Question: What form of chart is displayed?
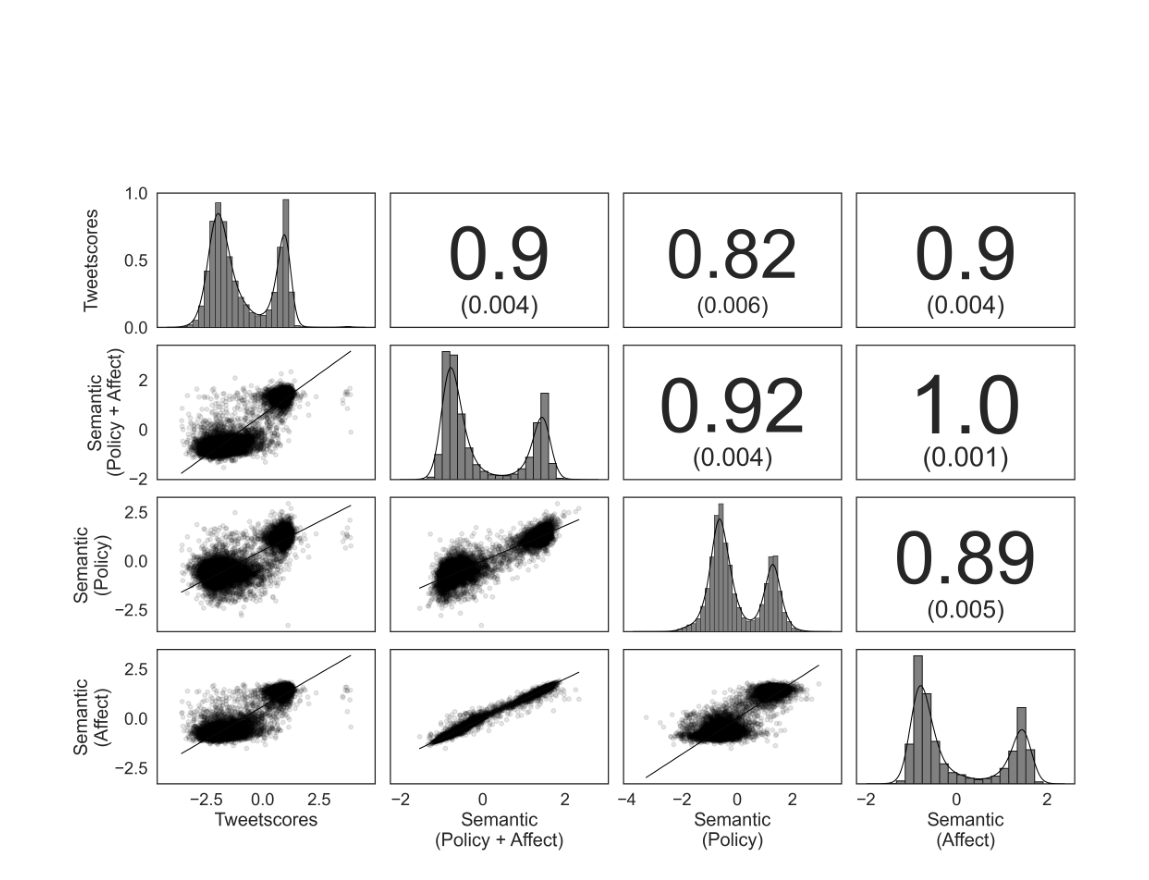
Answer: line